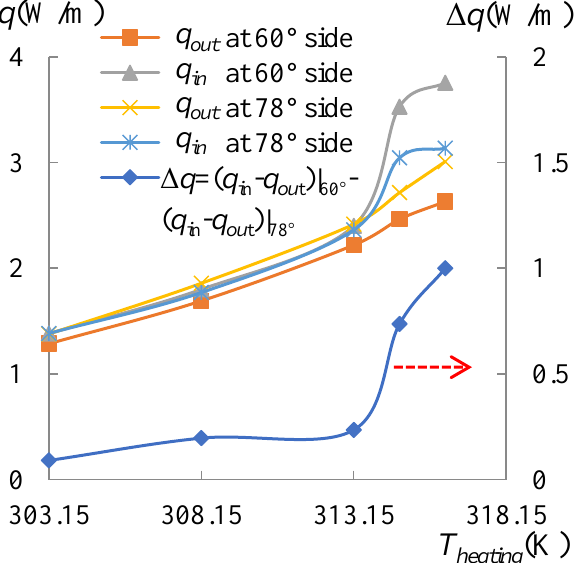
Figure 15. The input, output, and differential heat flow for T s = 303.15 to 316.15 K. There was a great jump in the input powers for both sides when T s = 313.15K. Furthermore, the differential heat flow indicating the power differential between both sides had a great jump as well.